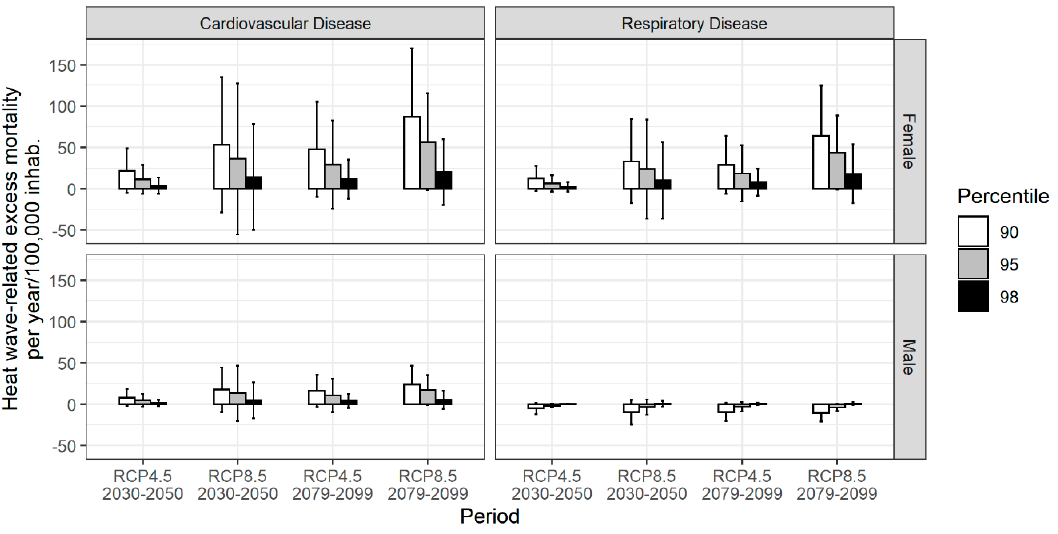
Figure 5. Heat wave-related excess mortality of elderly people per year in each 100,000 inhabitants from cardiovascular and respiratory diseases for female and male genders. Projections for near future (2030–2050) and distant future (2079–2099) under RCP4.5 and RCP8.5 climate change scenarios considering the adaptation assumption. The colors are percentiles of maximum temperature (90th, 95th and 98th).